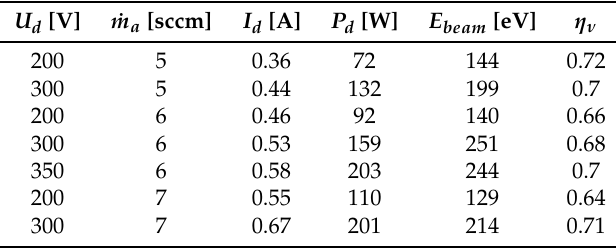
Table 6. Beam voltage for each investigated operating